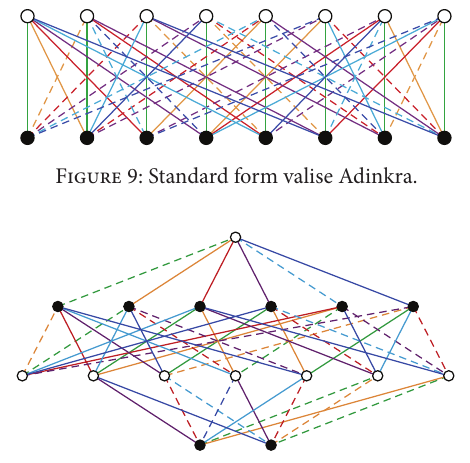
Figure 10: Adinkra after step